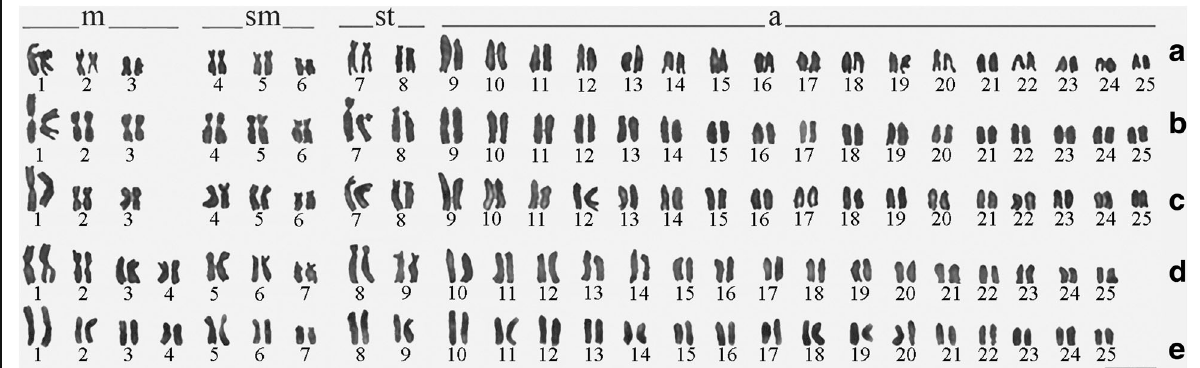
Fig. 1 Karyotypes of Cheirodon species occurring in Chile. ( a ) Ch. interruptus , ( b ) Ch. pisciculus , ( c ) Ch. galusdae , ( d ) Ch. kiliani , and ( e ) Ch. australe arrangend from Giemsa-stained chromosomes. Chromosomes were grouped as metacentric (m), submetacentric (sm), subtelocentric (st), and acrocentric (a). Bar equal 10 μ